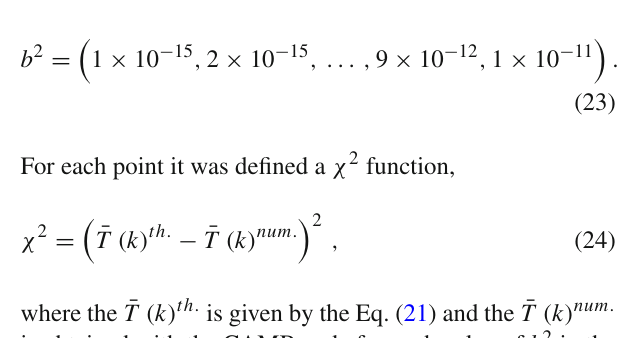
Fig. 7 Total matter perturbation in the Fourier space. The solid line corresponds to Λ CDM model, the dotted line corresponds to WDM case (thermal relics) with mass 3.5 and 5.3 keV, and the dashed line corresponds to the RRG approach with their respective values of b